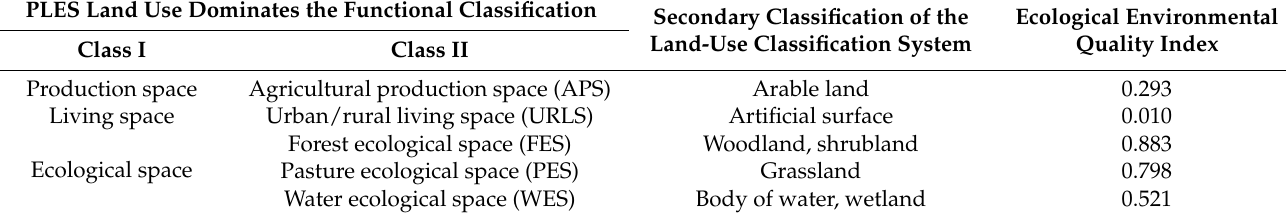
Table 1. Association of the PLES classification system with the land-use